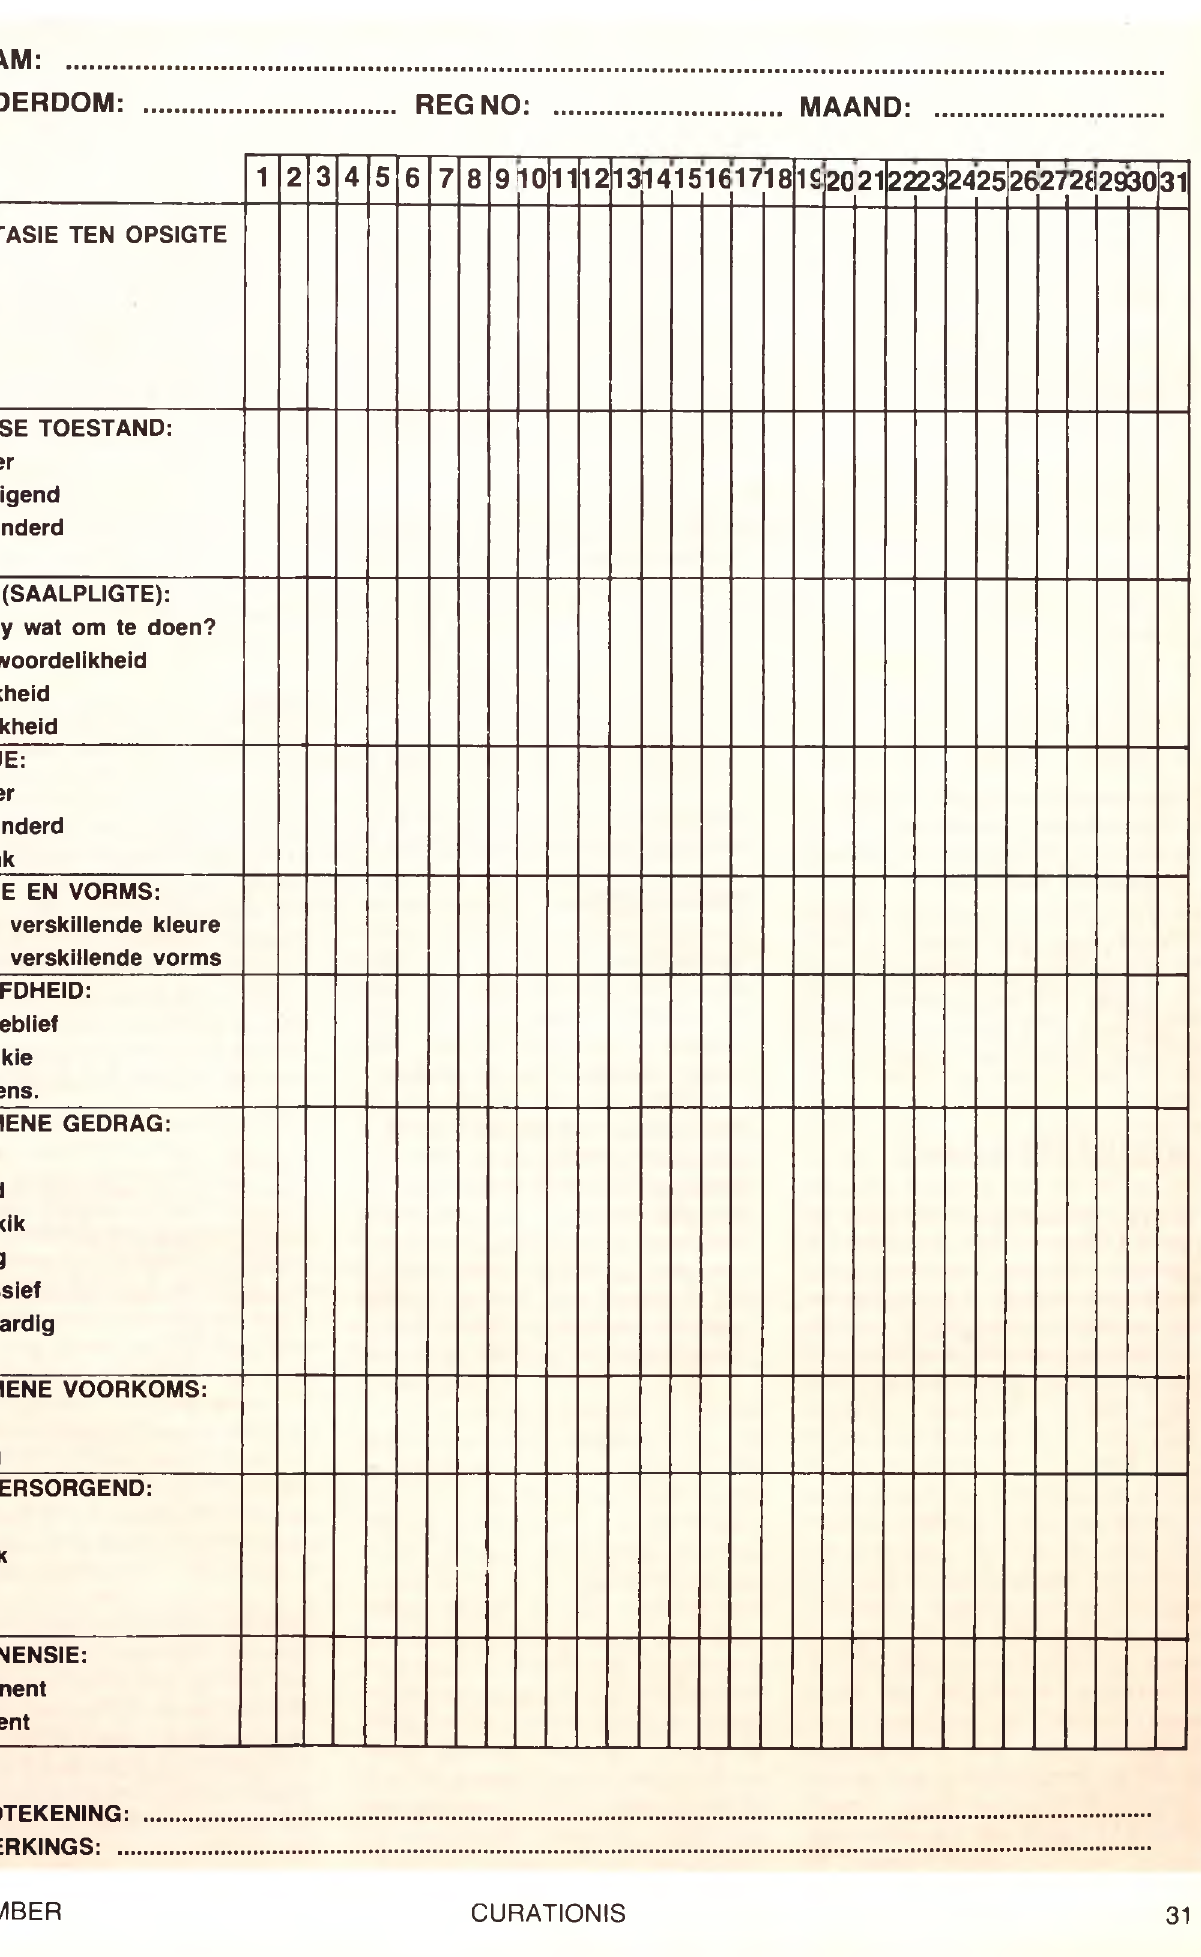
Verbeter Bevredigend Onveranderd WERK (SAALPLIGTE): Weet hy wat om te doen? Verantwoordelikheid Deeglikheid Stiptelikheid GEHEUE: Verbeter Onveranderd Verswak KLEURE EN